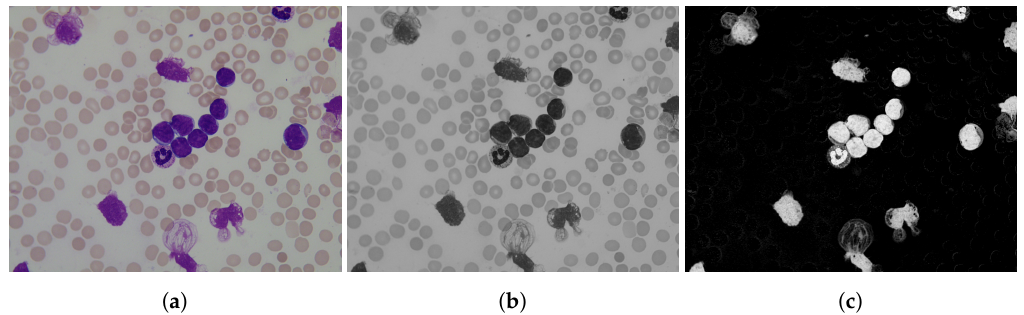
Figure 5. ( a ) Original RGB image, ( b ) grayscale image, and ( c ) preprocessed image exploiting both the hue and saturation